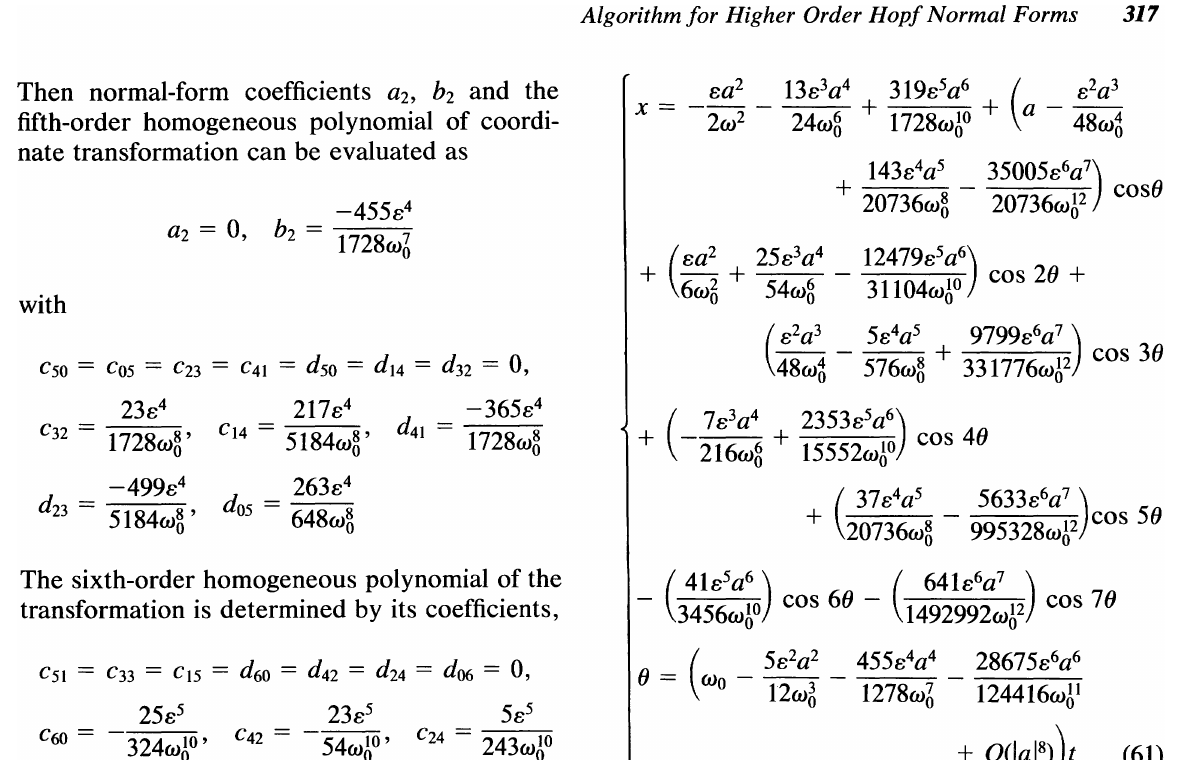
Algorithm for Higher Order Hopf Normal